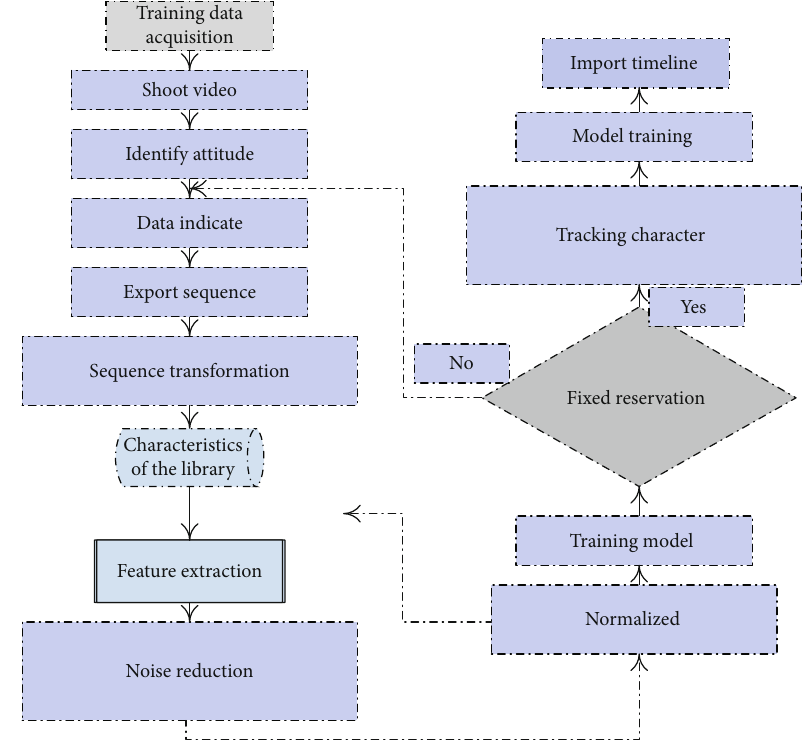
Figure 3: Data processing fl ow chart of fi lm and television production. Table 2: Image scene boundary detection test data